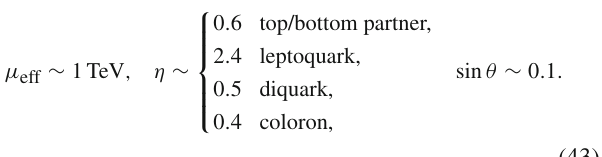
Fig. 10 In each panel, the line corresponds to the preferred contour to explain the 2.4 σ excess at m s = 300GeV, and the shaded region is excluded at the 95% CL by σ( Z Z → 4 l ) 13TeV . The K -factor is set